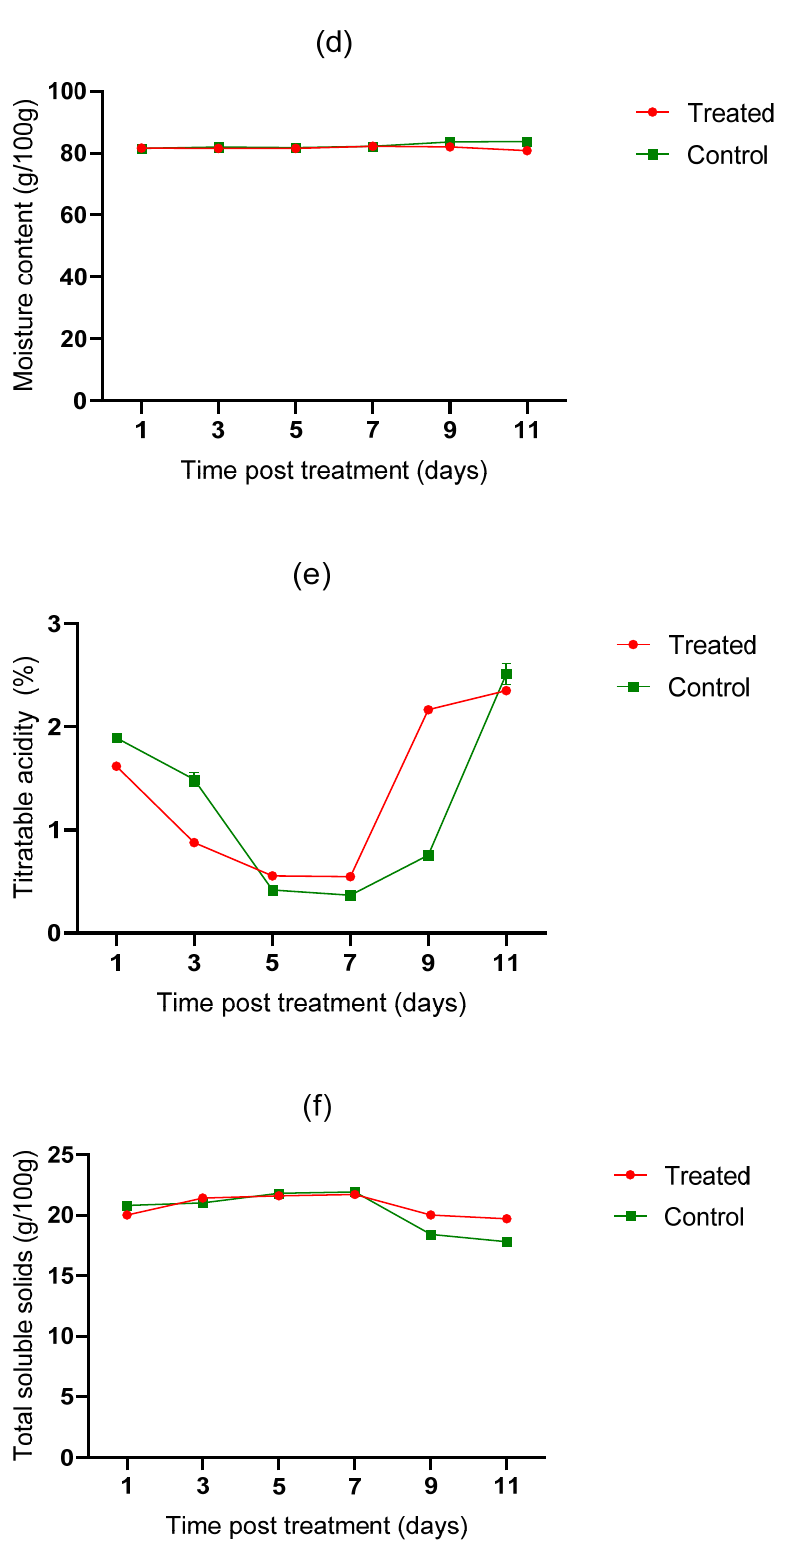
Figure 2. Changes in weight loss ( a ), fruit firmness ( b ), pulp pH ( c ), moisture content ( d ), titratable acidity ( e ), and total soluble solids ( f ) in cv. Tommy Atkins mango after HWT.